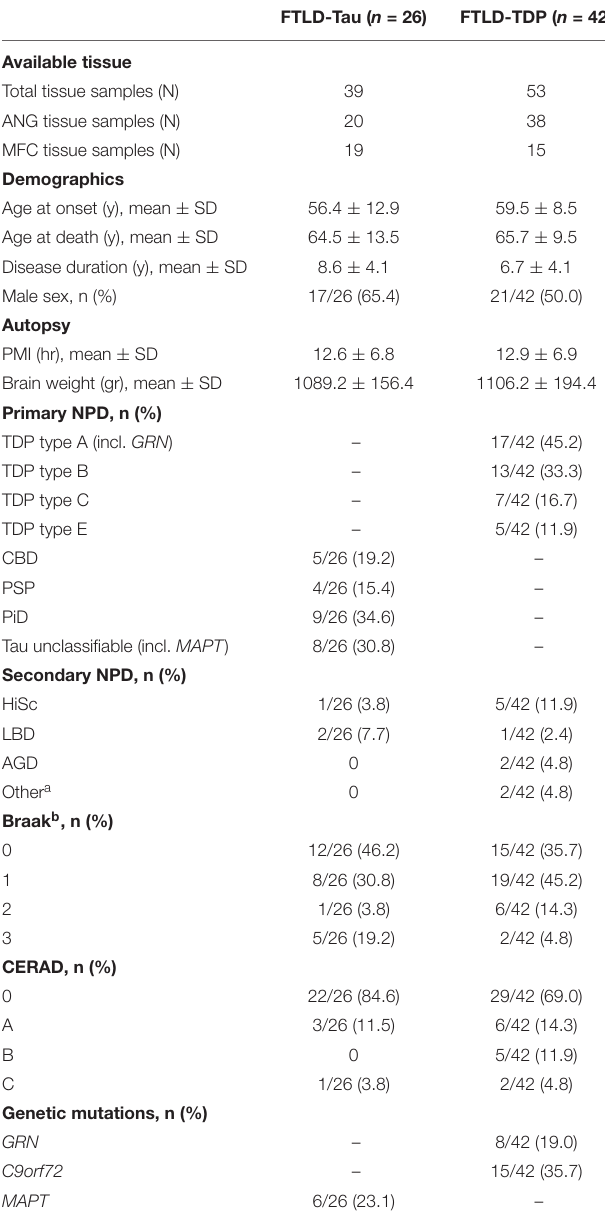
TABLE 1 | Demographic and pathologic characterization of the